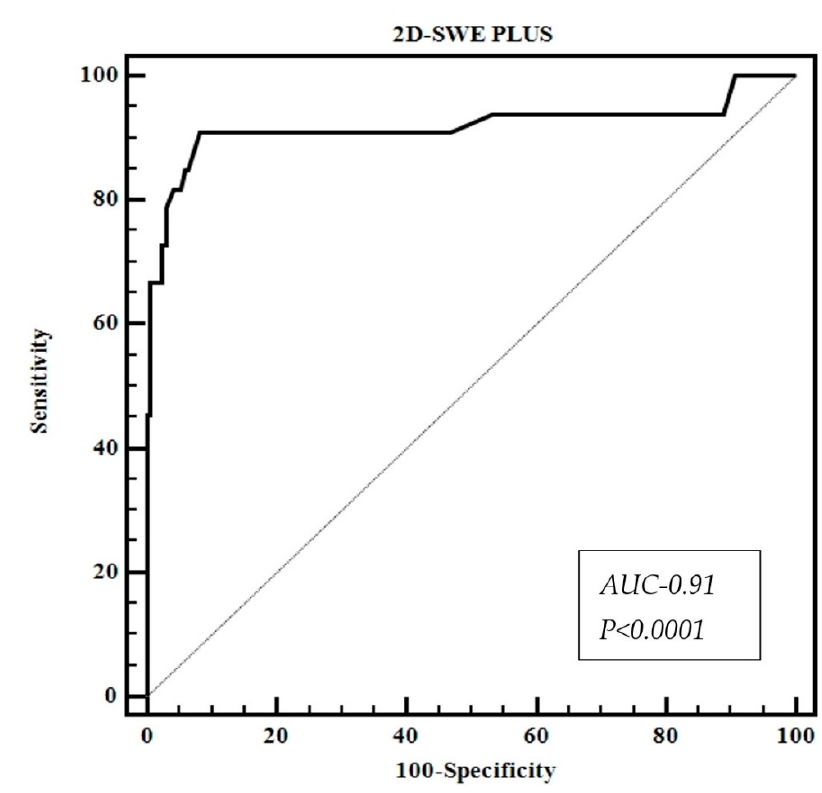
Speed Plane-wave Ultrasound, Att.PLUS = Attenuation Plane-wave Ultrasound.